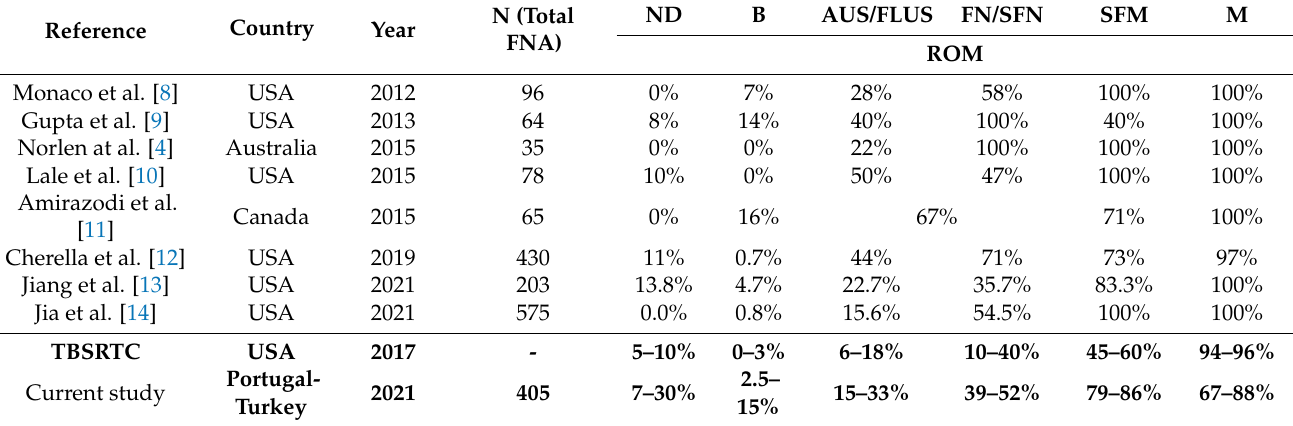
Table 4. Brief literature review of the distribution of TBSRTC categories based on ROMs [4,8–12].